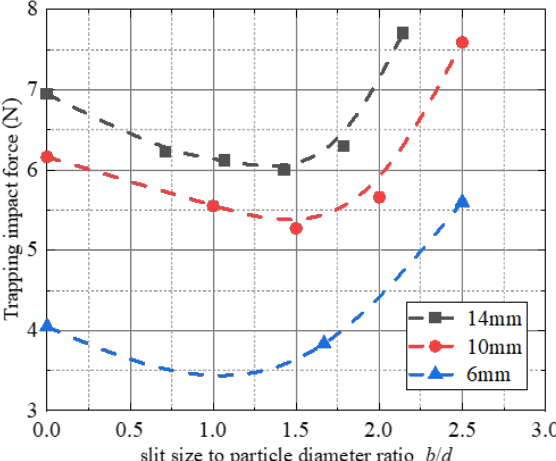
Figure 10. Trapping impact force of particles on inclined baffle structure under different relative opening widths.